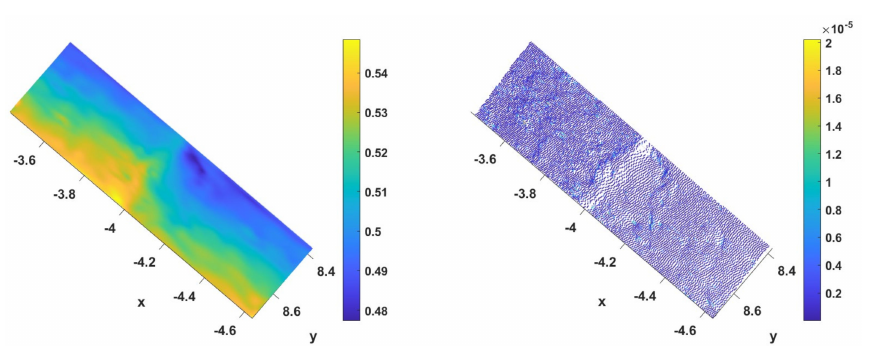
Figure 13. Left : T-spline surface E00 in (m) with reduced z-component (m); right : residuals of the approximation in (m). Table 4. Results of the approximation for E00 and E55. The same criteria as in Table 1 are chosen to judge the goodness of fit. Threshold: 0.5 mm; number of iterations: nine. RMSE for Max Error Nb of Control Reference (mm) (mm)/Nb of Errors Points/Computational Time (s) E00 9.0 × 10 − 1 3.8/8 1141/45 E00 with NURBS 7.8 × 10 − 1 3.6/56 3550/305 E55 898/43 E55 with T-mesh 5/65 from E00